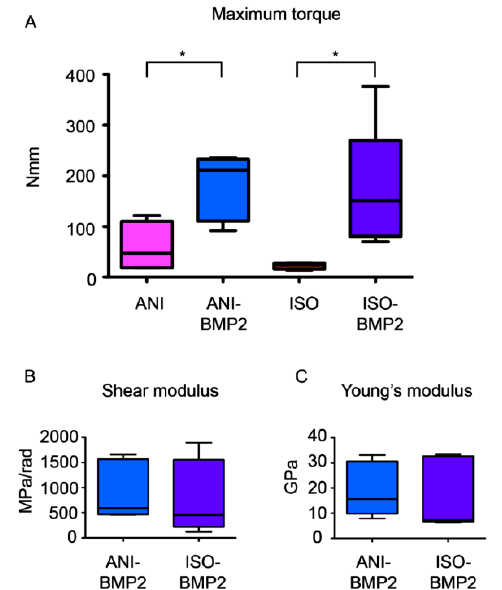
Figure 6. Determination of the biomechanical properties of the repaired bones. ( A ) Maximum torque of the different groups was determined. *, p < 0.05 by one Kruskal–Wallis test (p = 0.0129) and followed by Dunnett’s multiple comparisons test. No differences were found in shear modulus ( B ) and Young’s modulus ( C ) between anisotropic scaffolding bone morphogenetic protein 2 (ANI–BMP–2) and isotropic scaffolding (ISO)–BMP–2 groups.